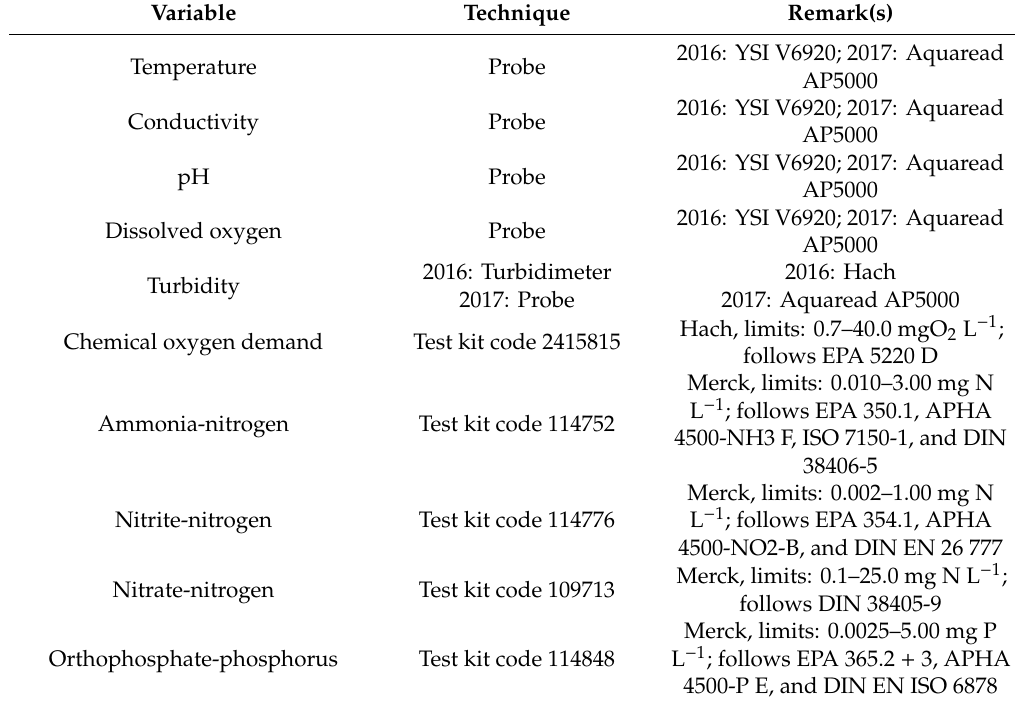
Table A1. List of physicochemical variables measured in 2016 and 2017 and the associated method.